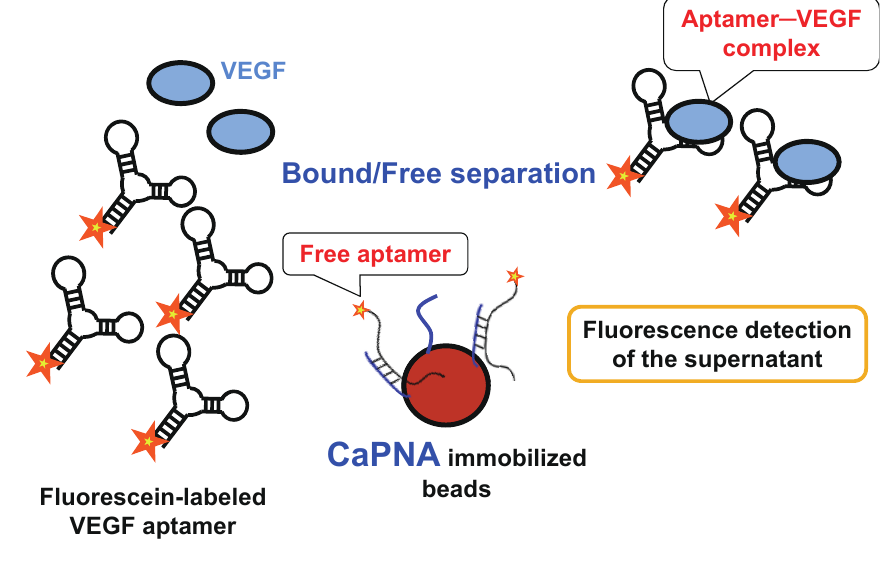
Figure 1. Scheme of the single aptamer-based bound/free separation system using captured peptide nucleic acids (CaPNAs). The fluorescein-labeled aptamer was incubated with target proteins. The mixture was then incubated with CaPNA-immobilized beads. After centrifugation, the fluorescence intensity of the supernatant was measured. In the absence of target molecules, the fluorescein-labeled aptamers were captured by CaPNA immobilized beads, resulting in a decrease in the fluorescence intensity. When the target molecule binds to the aptamer, hybridization between the aptamer and the CaPNA is inhibited due to stabilization of the aptamer structure and/or steric hindrance via binding of the target molecule, resulting in an increase in the fluorescence intensity of the